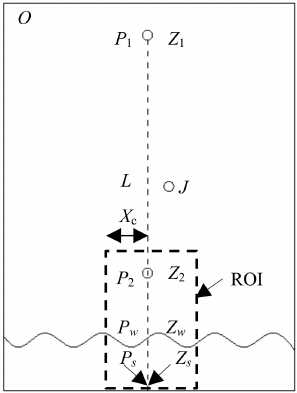
Figure 5. First frame image and related signs.